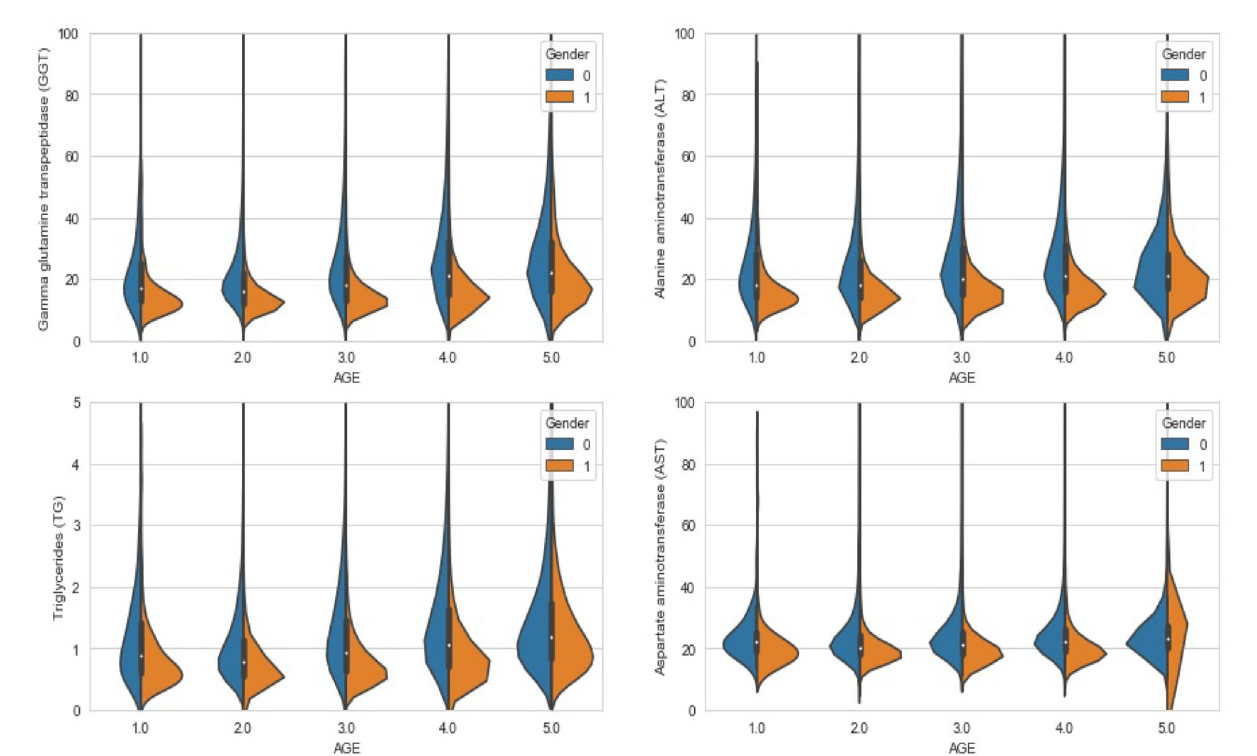
FIGURE 3 | Violin chart: the distribution of different features under different age groups and genders.